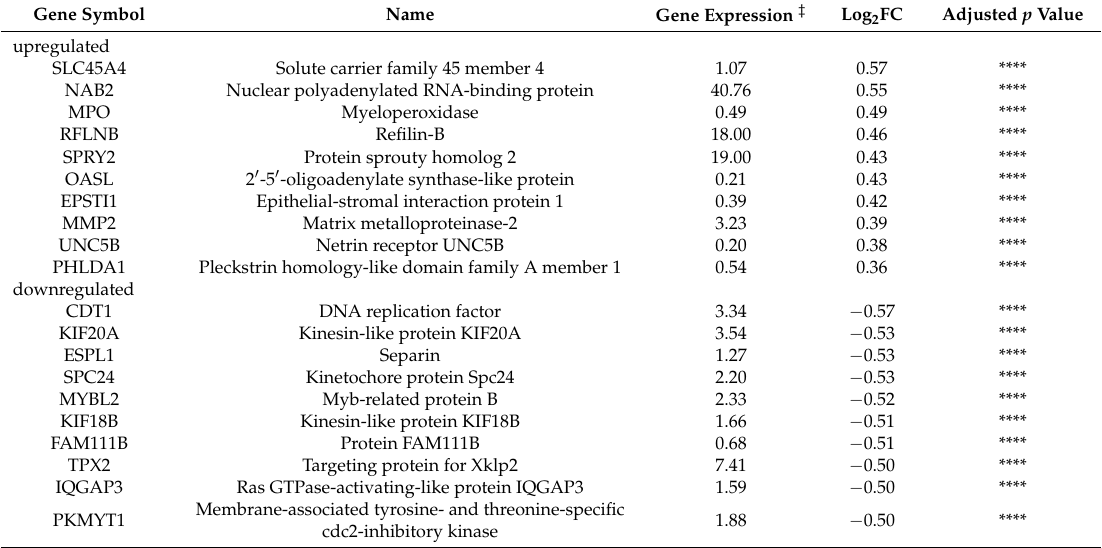
Table 1. The top 10 deregulated genes in CCS versus